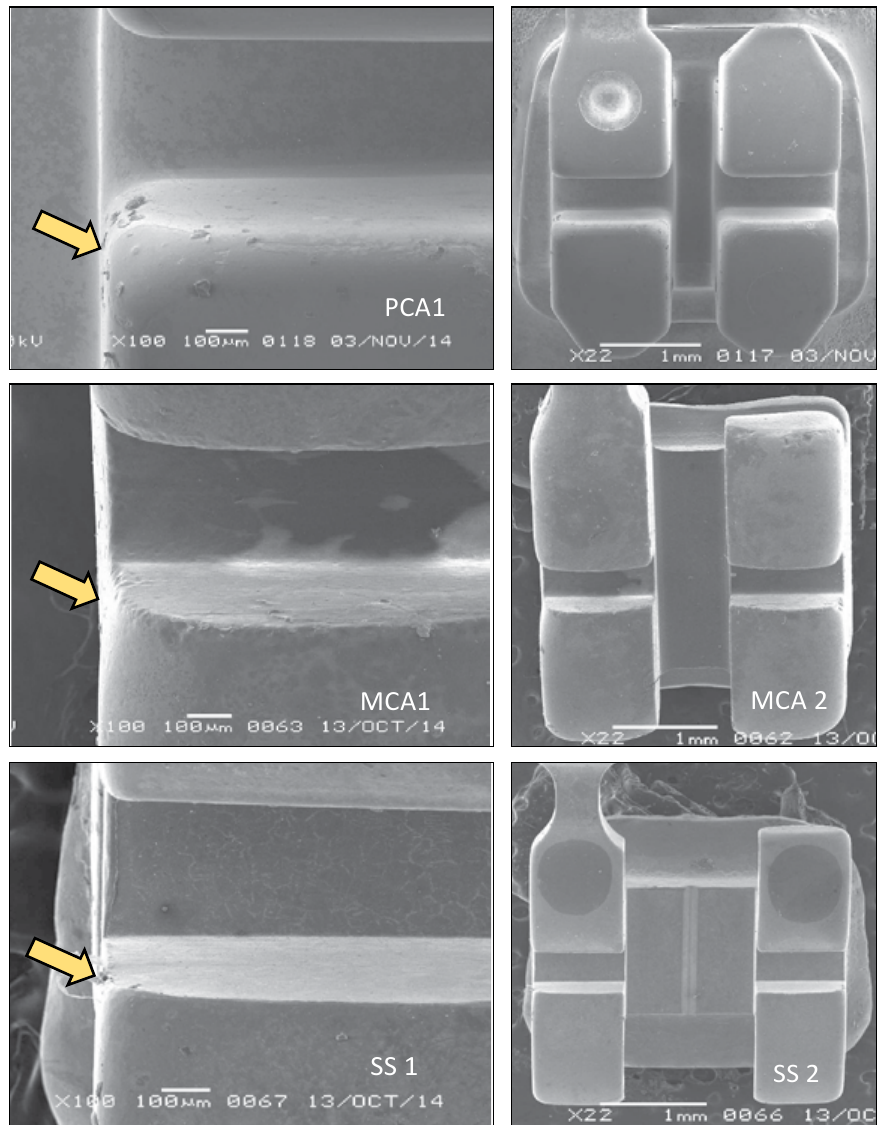
Figure 5. Photomicrographs obtained by scanning electron microscope. (1) Close-up view of the slot areas. (2) Overall view of the bracket design. (PCA) Polycrystalline ceramic brackets. (MCA) Monocrystalline ceramic brackets. (SS) Stainless steel metal brackets. Arrows pointing to ‘bevel area’ of the PCA brackets. The relationship between the bracket